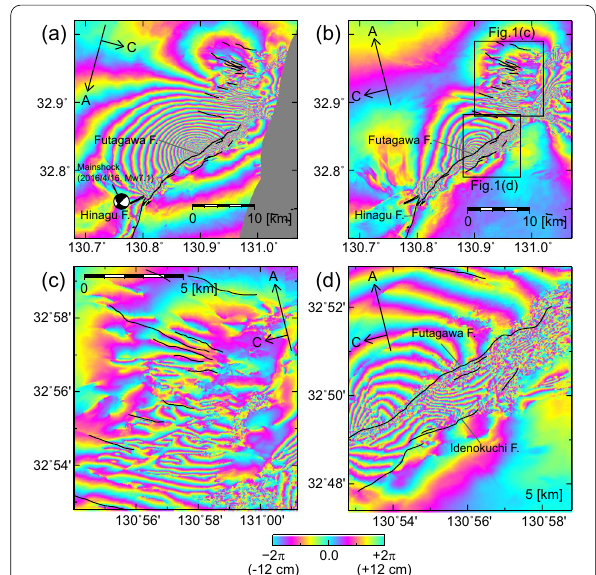
Fig. 1 PALSAR-2 interferograms depicting the crustal deformation associated with the 2016 Kumamoto Earthquake. Arrows in the figures indicate the along-track ( A ) and cross-track ( C ) directions. Thin curves indicate active faults cataloged in the digital map of active faults (Nakata and Imaizumi 2002). a, b Interferograms for Paths 28 (Descending, left looking) and 126 (Ascending, left looking), respectively. The two boxes correspond to the areas of ( c and d ). c , d Interferograms for Path 28, enlarged west of the Aso Caldera and Futagawa